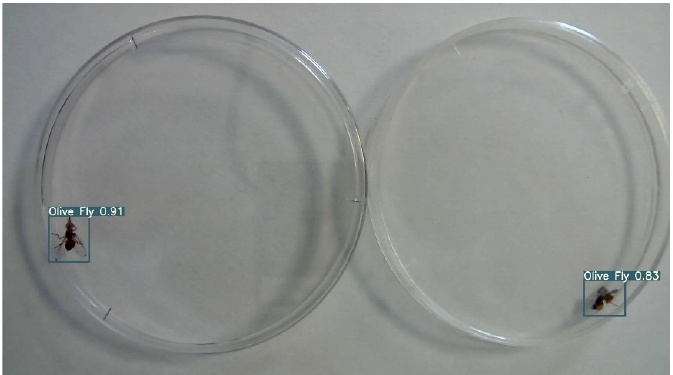
Figure 9 . Detection failed to recognize the Mediterranean fruit fly (right) in an angular pose (slightly blurred) of the insect’s body .